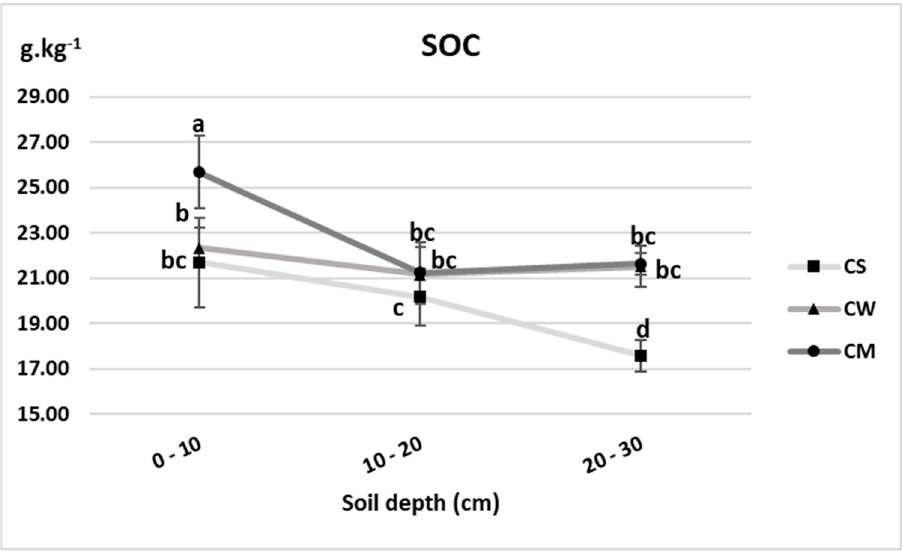
Figure 3. Soil organic carbon concentrations (g.kg − 1 ) of unplanted soil (CS), soil cultivated by wheat (CW) and soil cultivated by miscanthus (CM) at depths (0–10, 10–20 and 20–30 cm). Values are presented as means ± SD. Different letters refer to significant differences in soils (Fisher LSD test, n = 4, p ≤ 0.05).